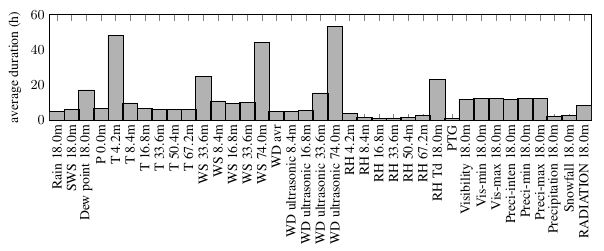
Figure 4. Average duration of missing readings.